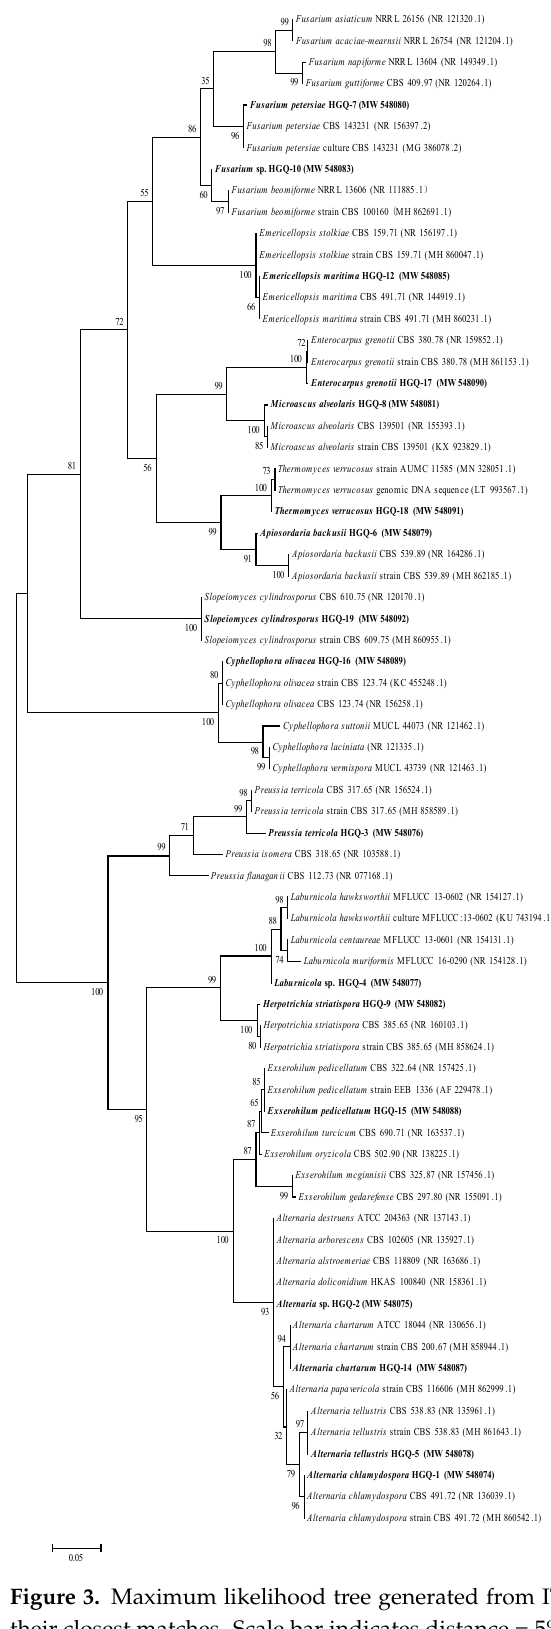
Figure 3. Maximum likelihood tree generated from ITS region sequences of isolated strains and their closest matches. Scale bar indicates distance = 5% nucleotide diversity. Sequences that were determined in the course of this study appear in bold.